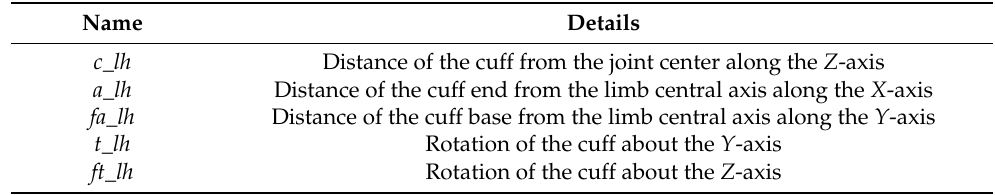
Table 1. Generalized Cuff Parameters Definition.